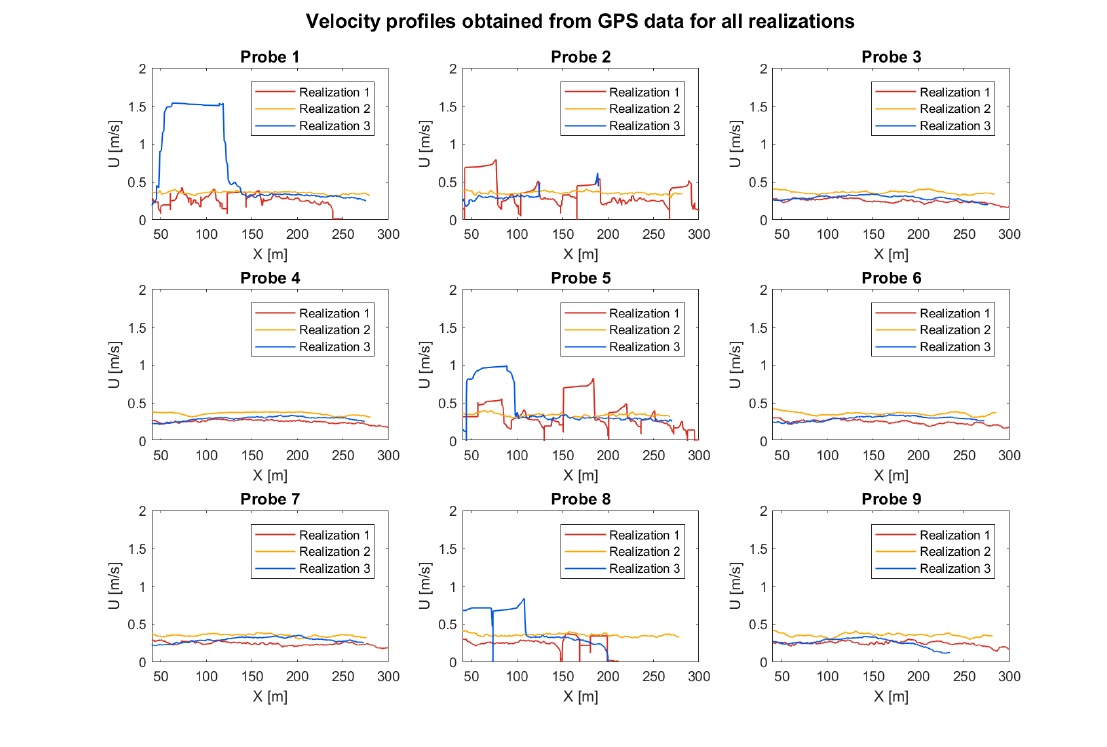
Figure 15. Velocities obtained by GPS